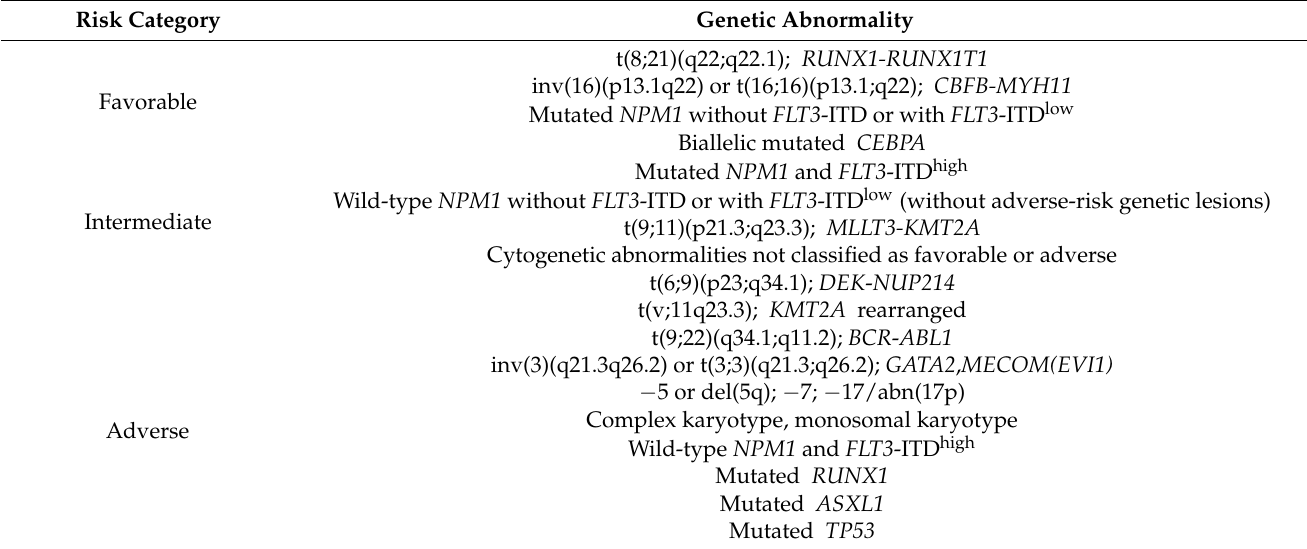
Table 2. The 2017 European Leukaemia Network risk stratification of AML [69]. Risk Category Genetic